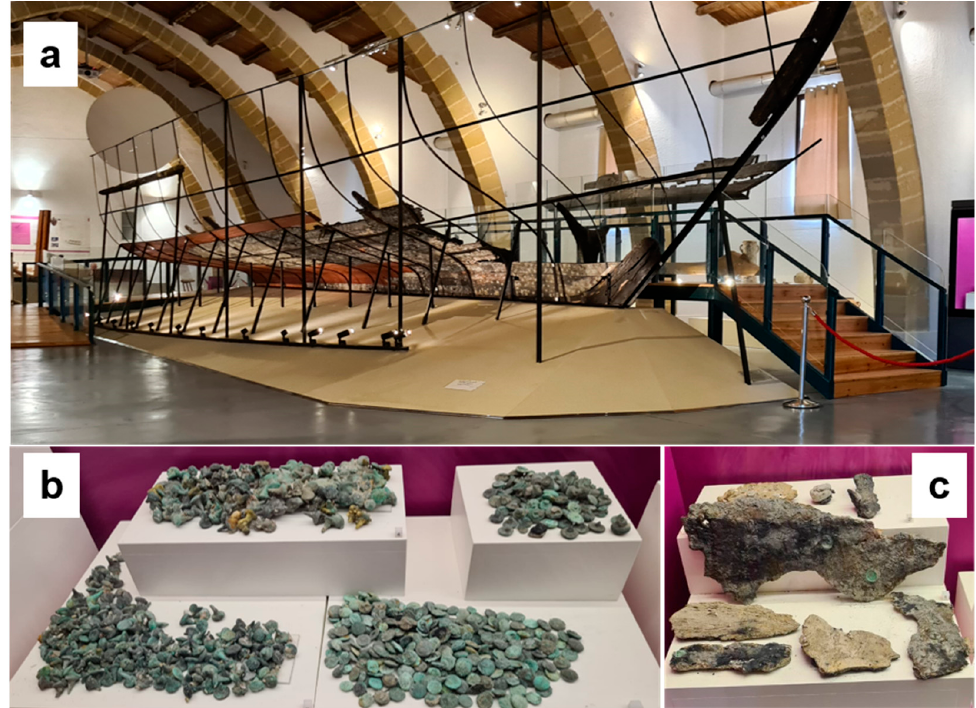
Figure 1 . ( a ) Photo of the wreck of the Punic ship exhibited at the Archaeological Park Lilybaeum where nails are inserted in the wood; ( b ) nails and ( c ) sheathings in the showcases.